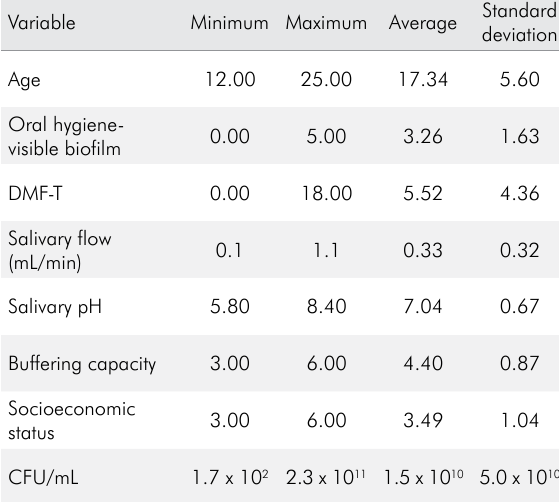
Table 1. Description of the average, minimum and maximum values found for the variables studied in individuals with